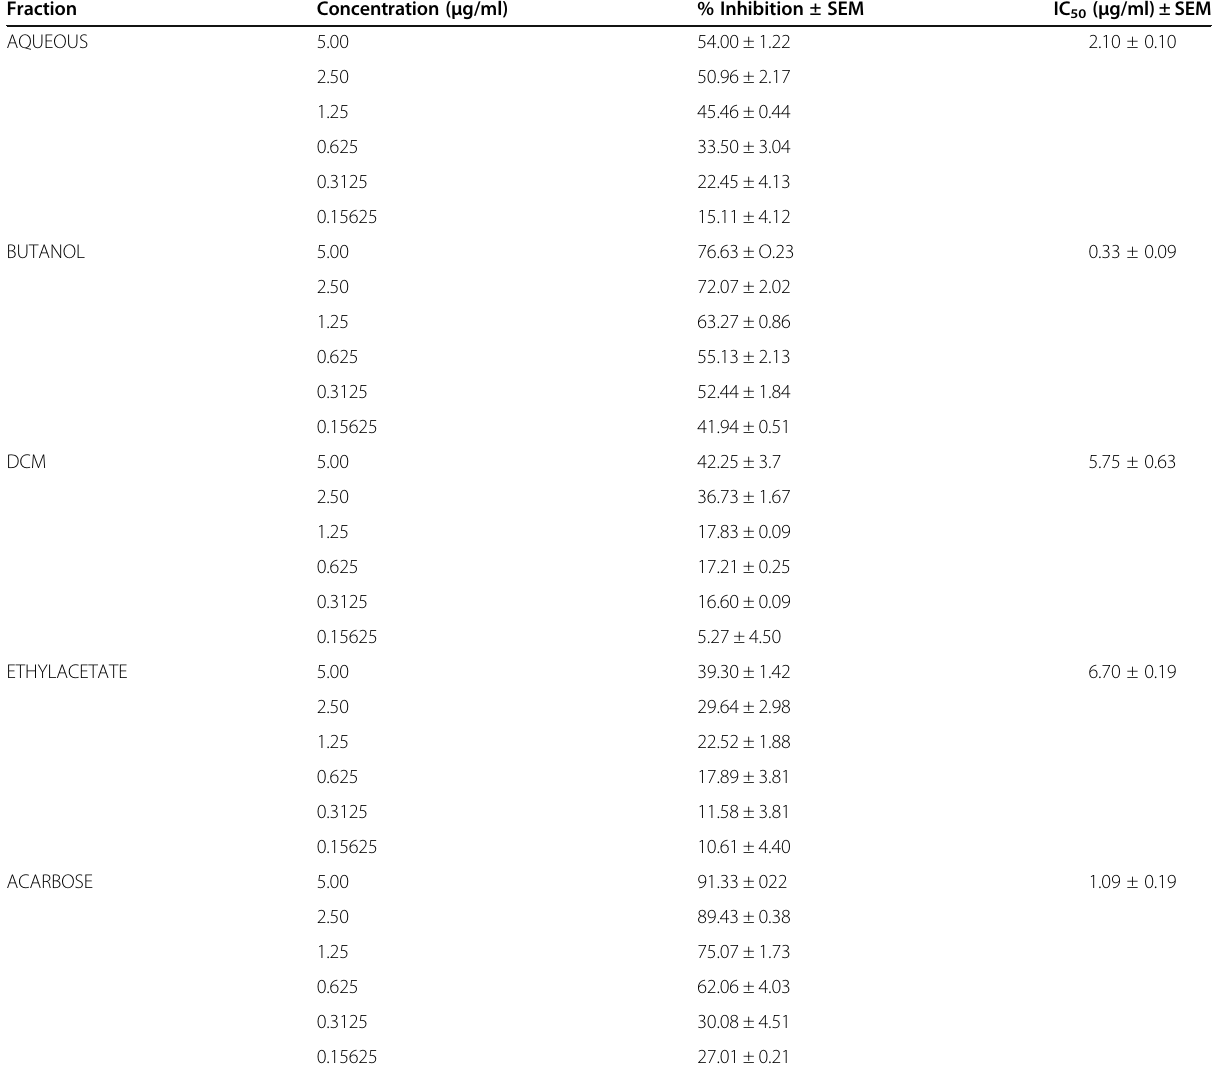
Table 2 In vitro inhibitory aactivities of different solvent fractions of P. guineense on α